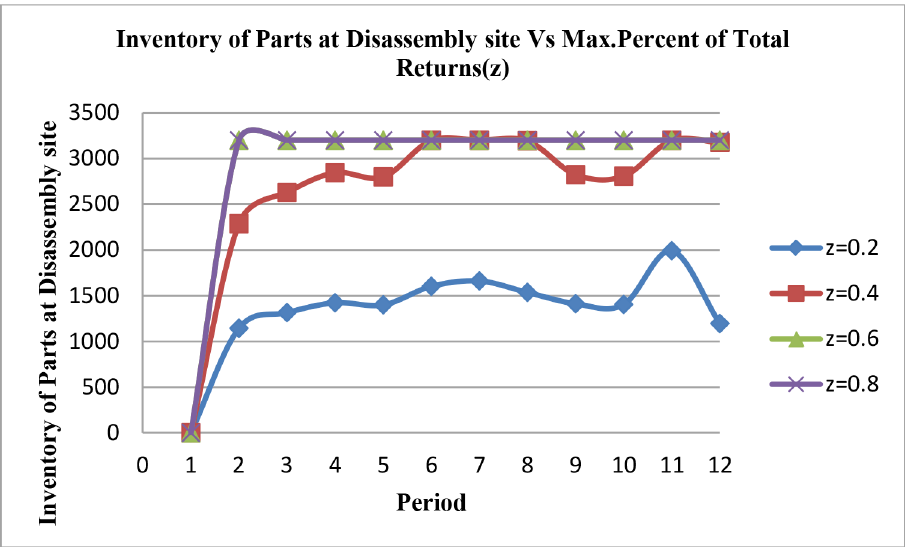
Figure 3. Inventory of parts at Disassembly site at multiple